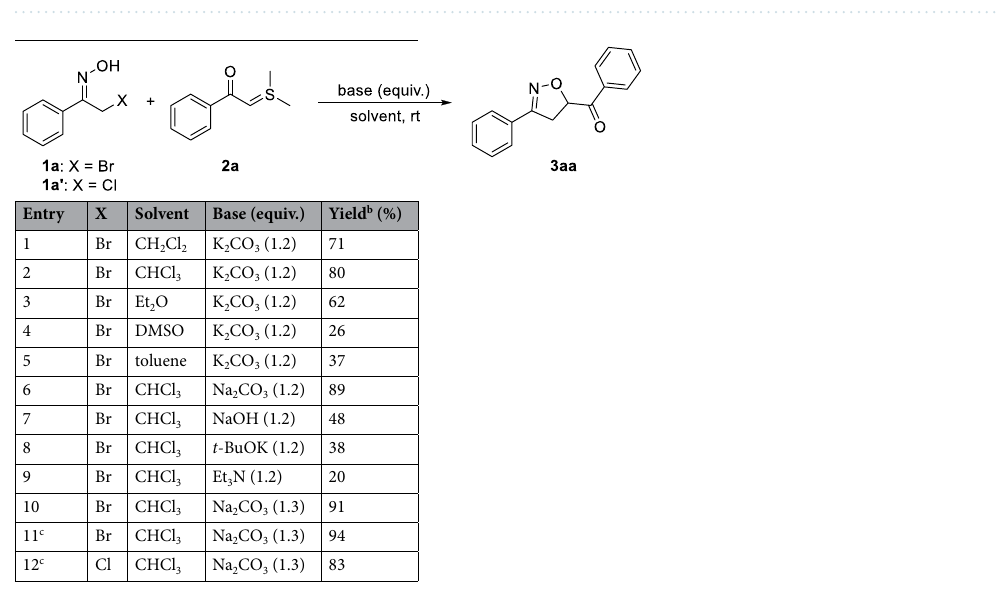
Figure 1. Synthetic transformation of transient nitrosoalkenes from α-halooximes: ( a ) [4 + 2] cycloaddition with electron-rich heterocycles or nucleophilic olefins; ( b ) conjugate addition reactions with various nucleophiles; ( c ) [4 + 1] annulation with sulfur ylides.